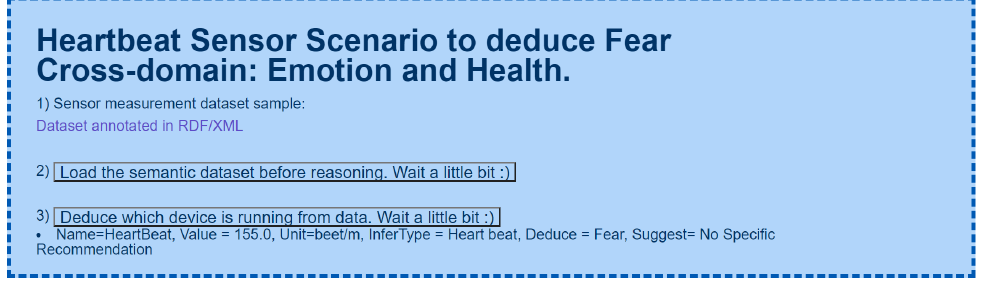
Figure A12. Deducing fear from heartbeat